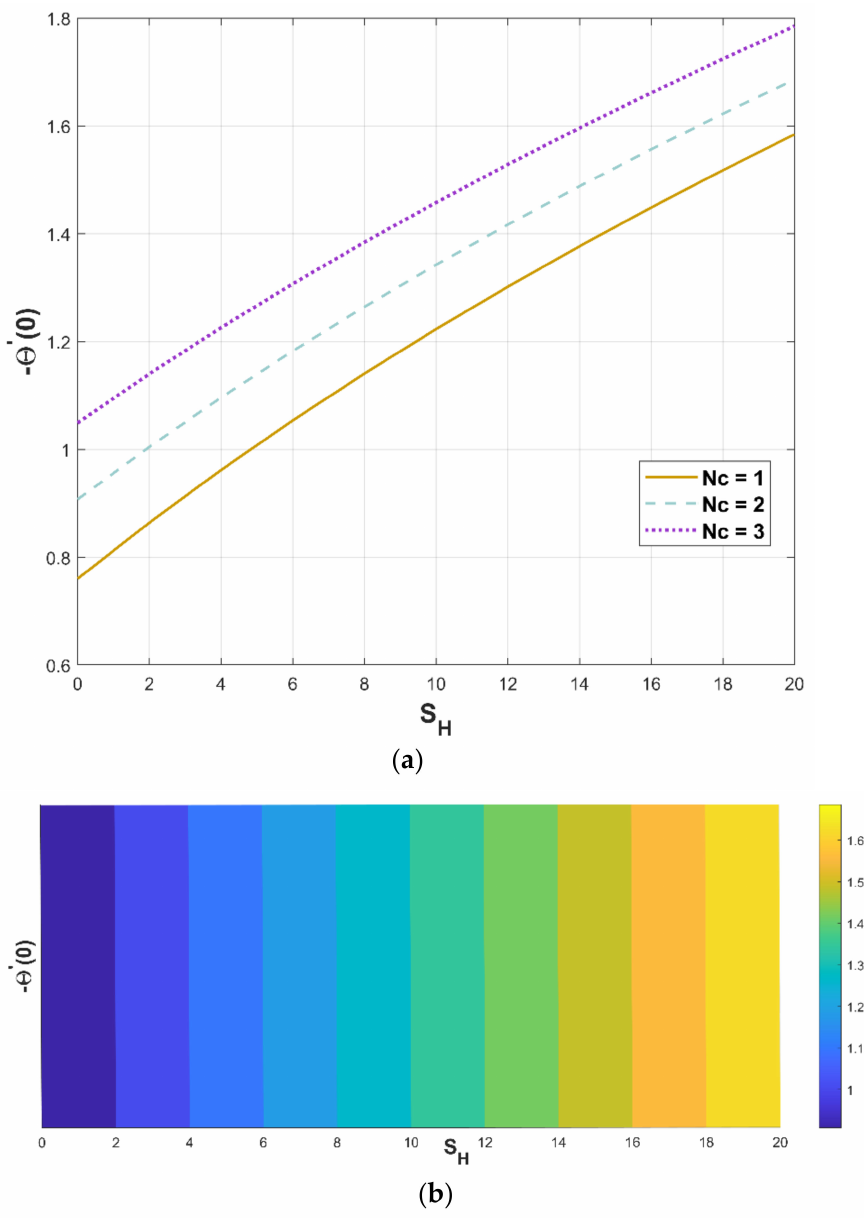
Figure 12. ( a , b ). Upshot of Nc and S H on − Θ (cid:48) ( 0 )